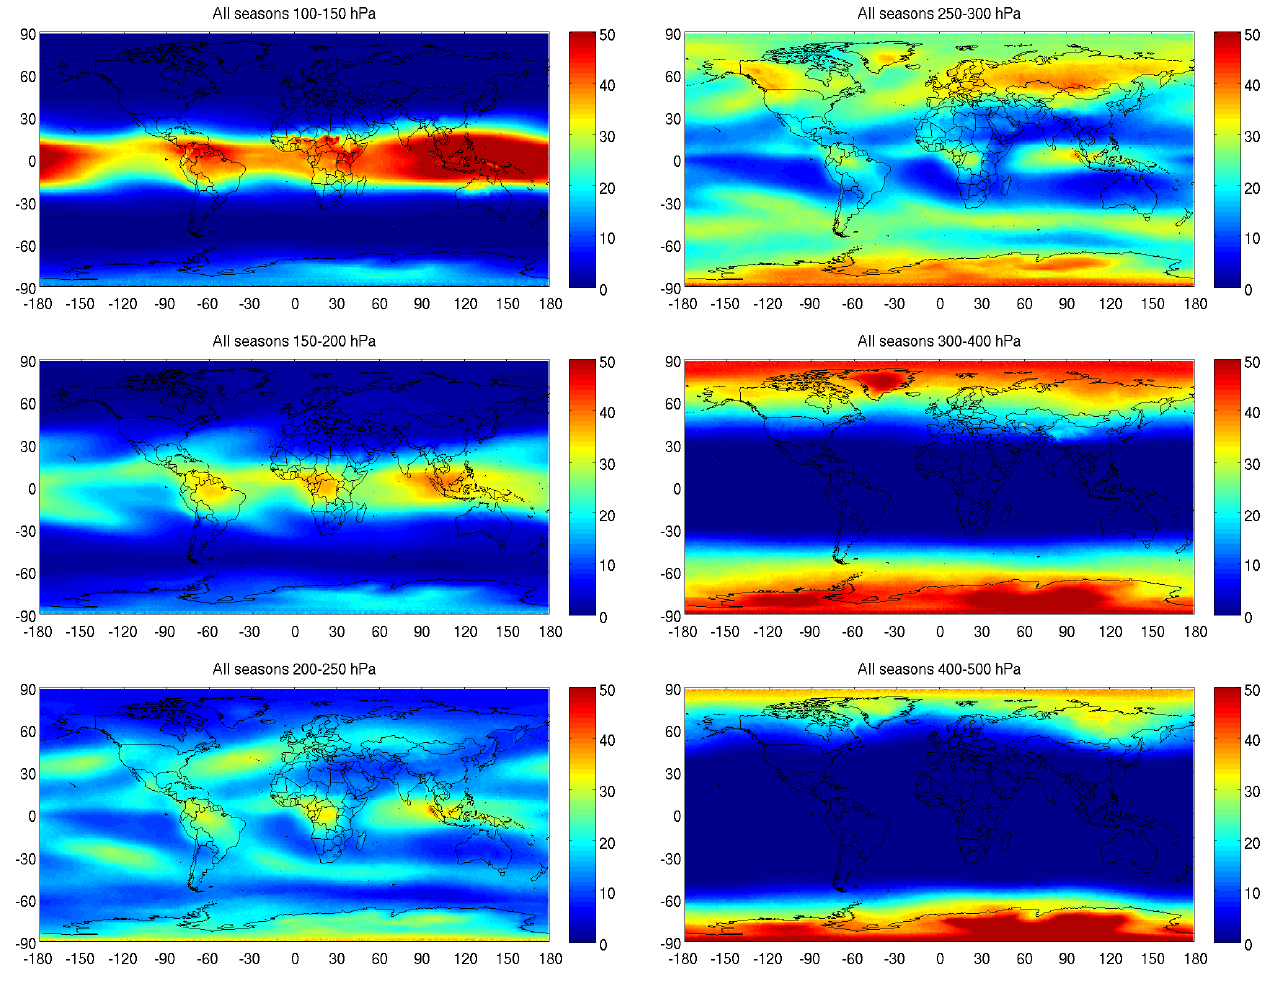
Fig. 9. Ice supersaturation occurrence frequencies (%) from AIRS in the pressure layers 100–150, 150–200, 200–250, 250–300, 300–400 and 400–500hPa. Only good quality data used. 7-yr statistics 2003–2009. Table 4. Parameters a and b of the Weibull distributions fitted from the histograms of Fig. 8 and their correlation